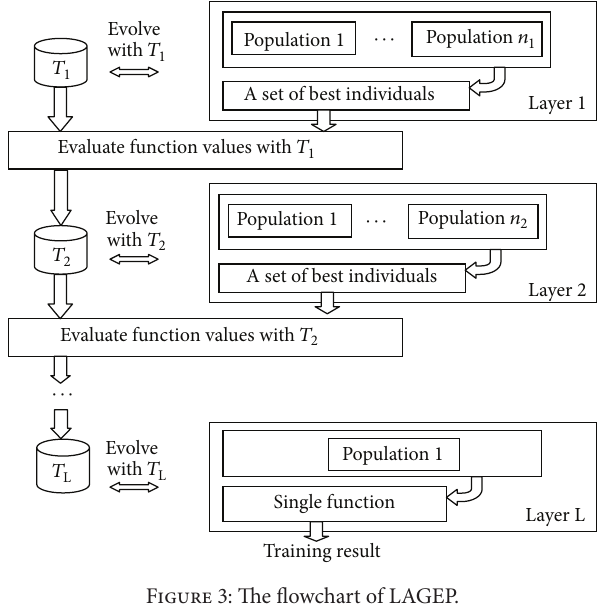
Figure 3: The flowchart of LAGEP.